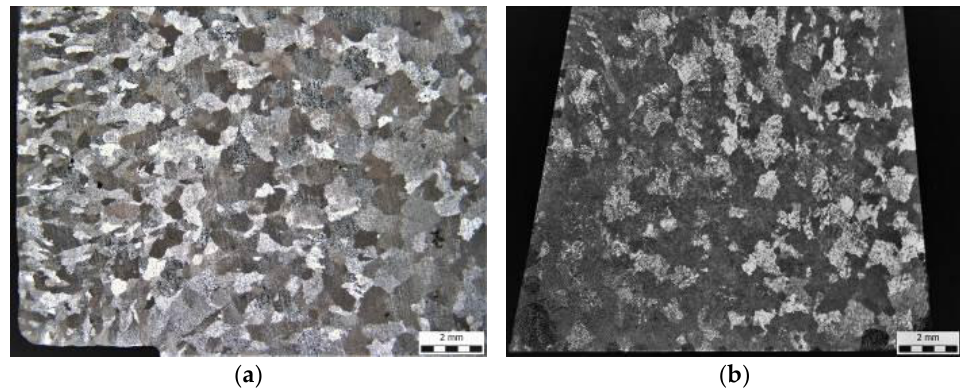
Figure 4. The macrostructure of the sample in: ( a ) as-cast condition and ( b ) solution-hardened condition.